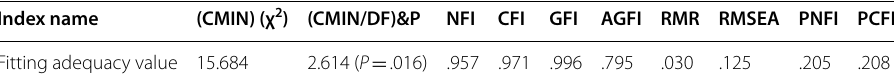
Table 7 Index of fix indices